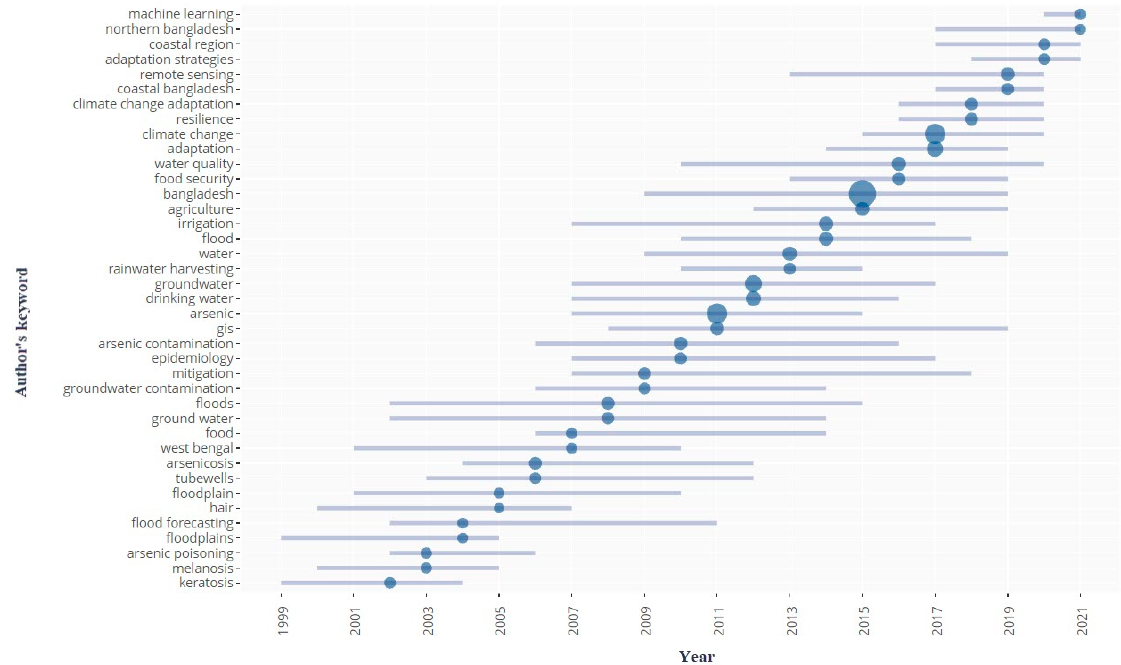
Figure 8. Trending topics in water-research-related publications in Bangladesh .